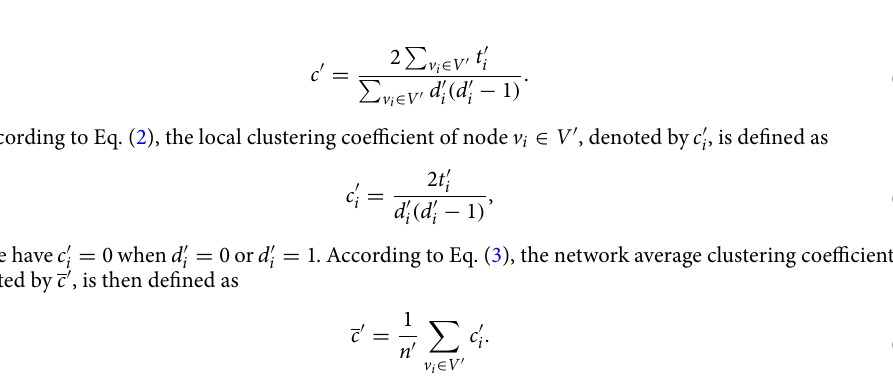
Table 1. Synthetic graphs generated by using Erdős–Rényi model (ER), Watts–Strogatz model (WS), and Barabási–Albert model